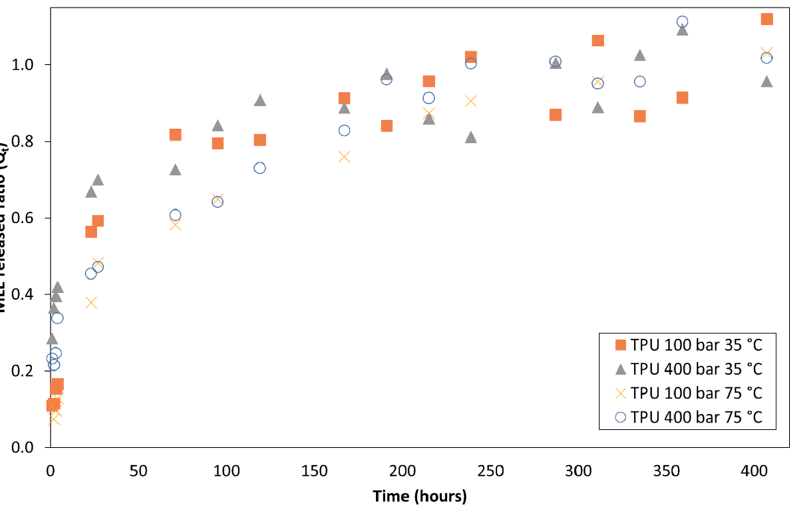
Figure 8. Mango leaf extract release profile from supercritical impregnated TPU at different impreg- nation